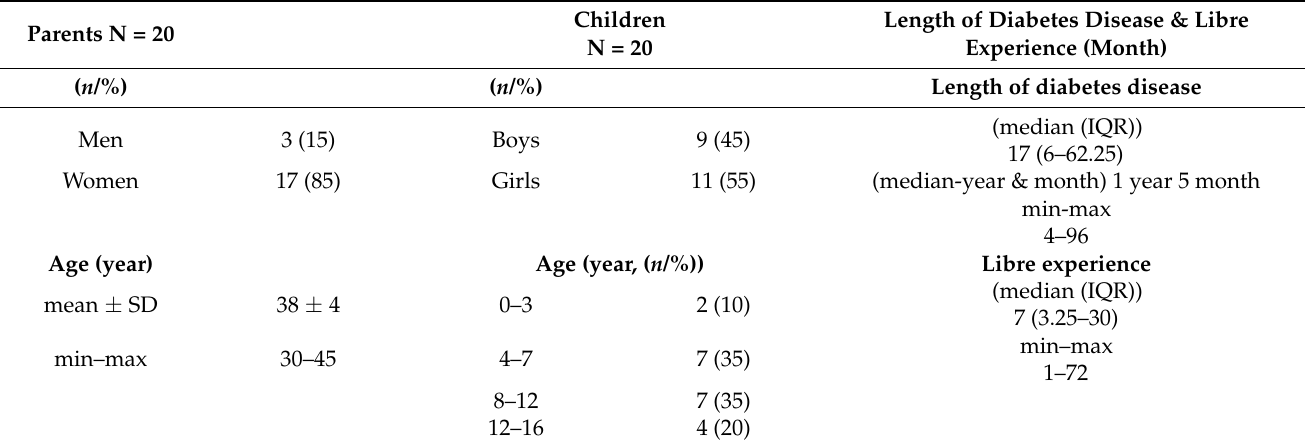
Table 1. Demographic parents (informants) and children characteristics, in absolute ( n ) and relative frequencies (%). Length of diabetes disease, and experiences of the Libre device in month (medians and interquartile range (IQR)).